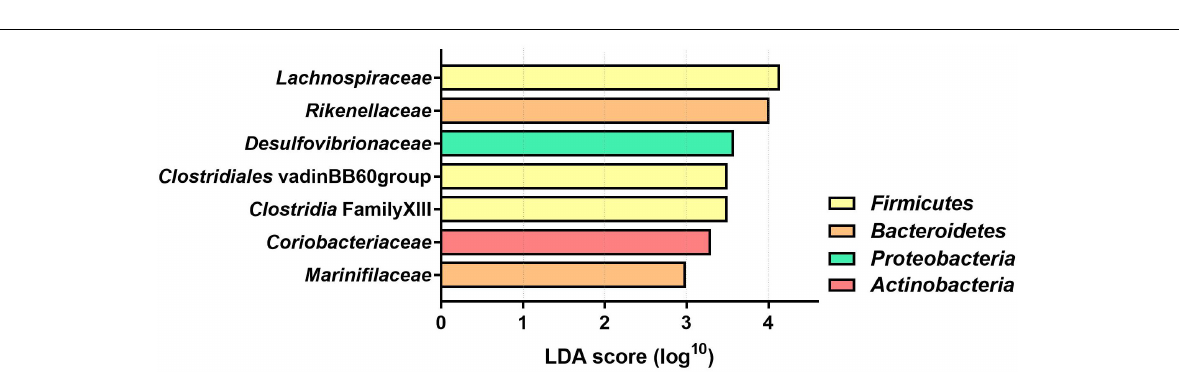
FIGURE 4 | Linear Discriminant analysis (LDA) score of differentially abundant bacterial families in the VDS − group. The effect of the UVB light exposures was calculated with a two-factor PERMANOVA, controlling for the interpersonal variation before and after the UVB light exposures. Only the bacterial families with significantly different ( p < 0.05) LDA score are depicted ( n = 46 samples collected from 12